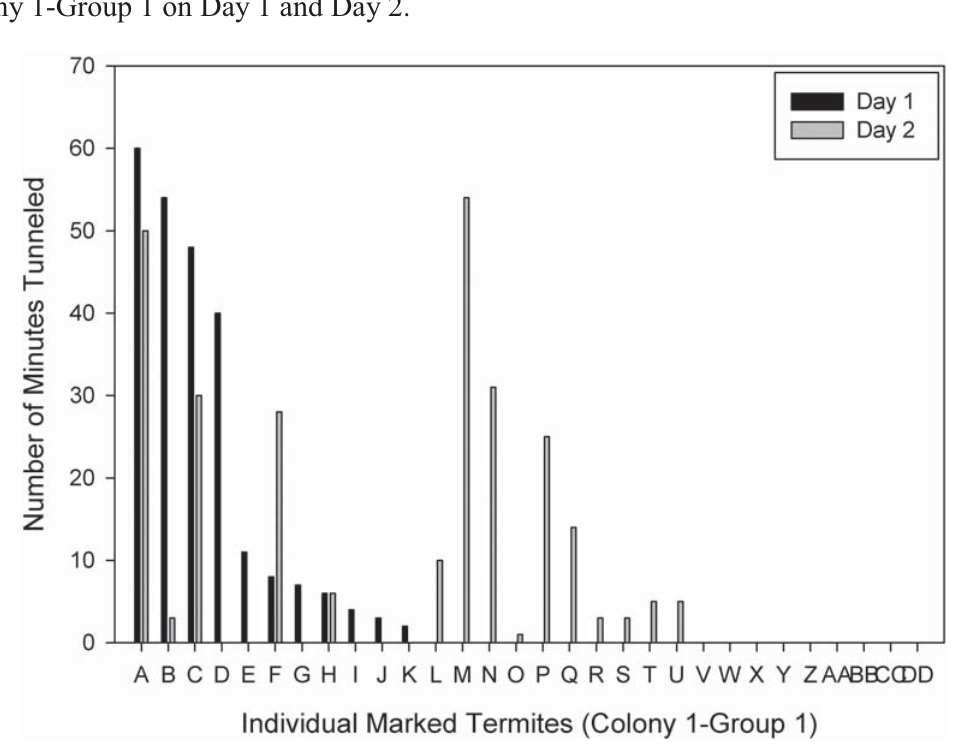
Figure 2. The number of minutes spent tunneling by each individual marked termite in Colony 1-Group 1 on Day 1 and Day